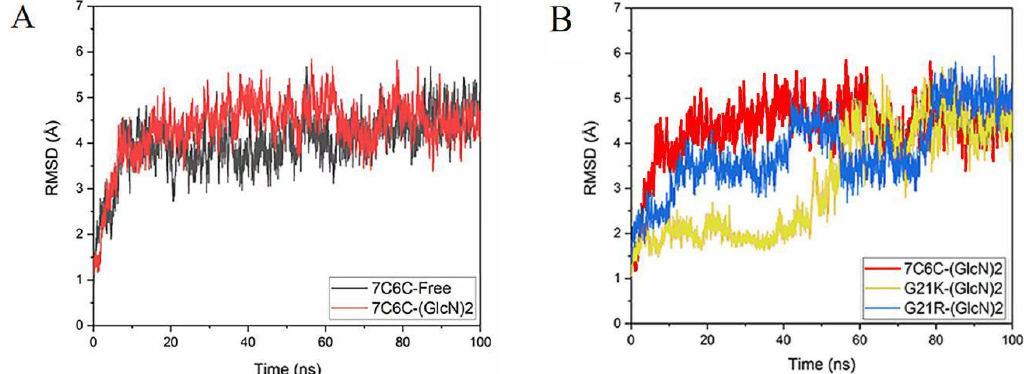
Figure 2. ( A ) RMSD plot of 7C6C-free and 7C6C-(GlcN) 2 complex; ( B ) RMSD plot of 7C6C-(GlcN) 2 , G21K-(GlcN) 2 and G21R-(GlcN) 2 . G21K-(GlcN) 2 and G21R-(GlcN) 2 . G21K-(GlcN) 2 and G21R-(GlcN) 2 .